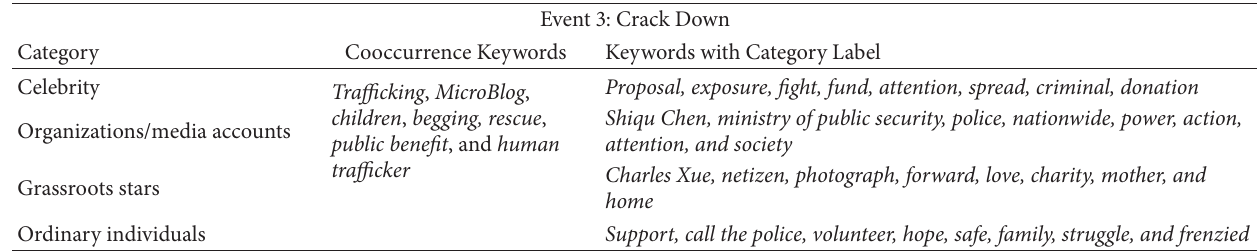
Table 7: Keywords distribution on the event of “Crack Down.”